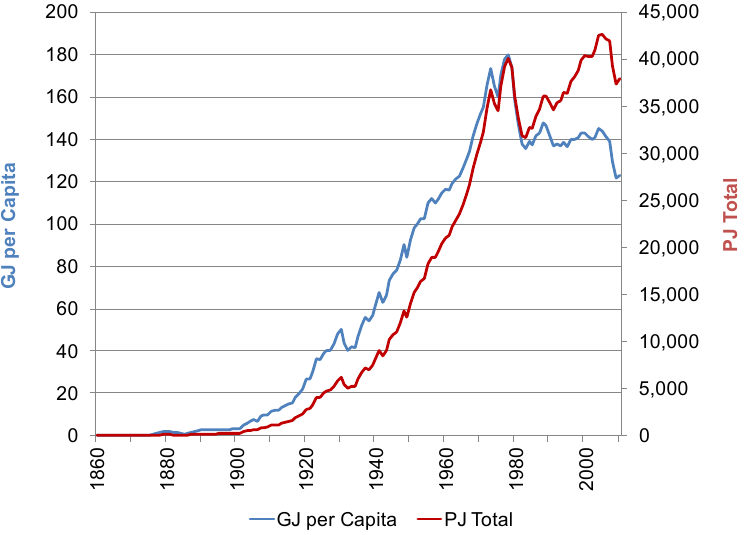
Figure 8. U.S. petroleum consumption, 1860–2010. Sources: [1] for 1860–1948; [25] for